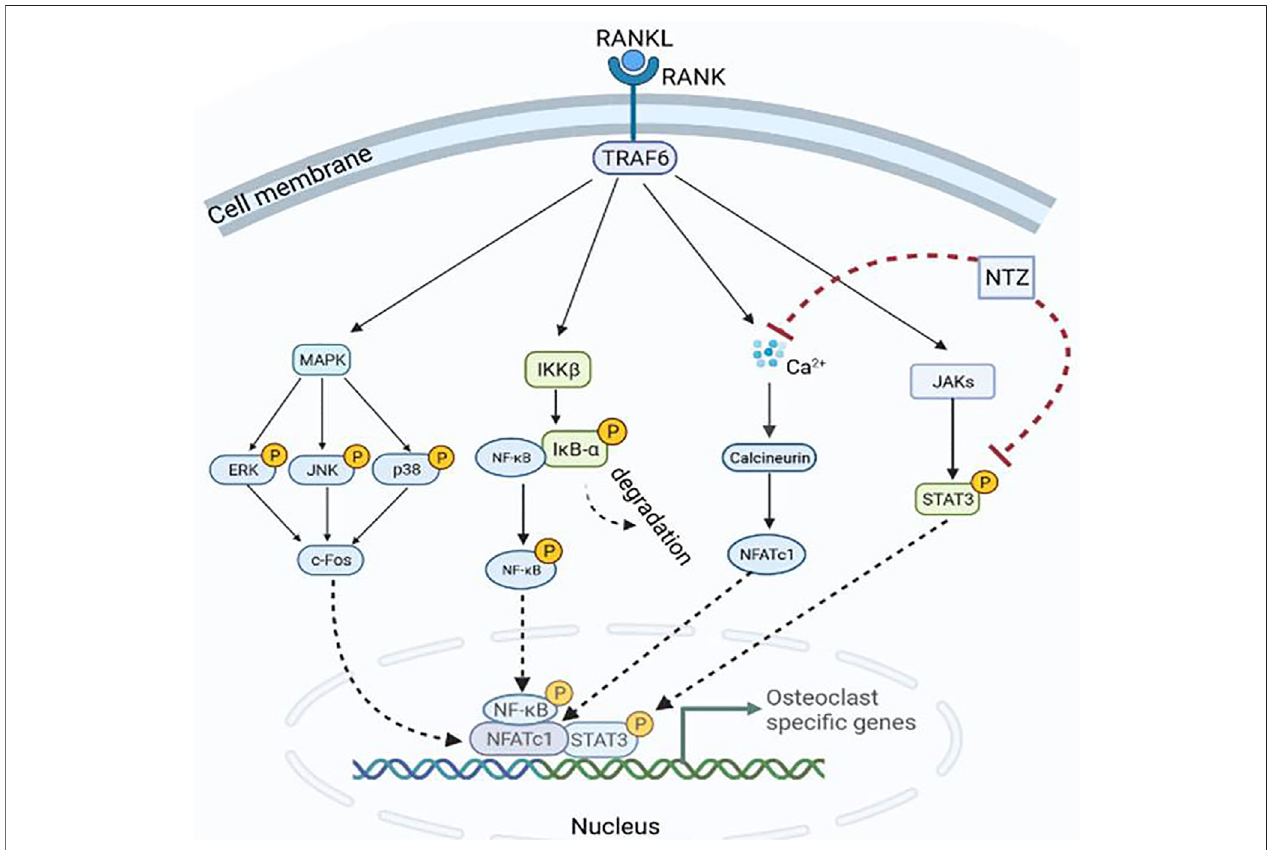
FIGURE 8 | A schematic diagram showing the proposed inhibitory mechanism of Nitazoxanide in inhibiting RANKL-induced osteoclastogenesis.